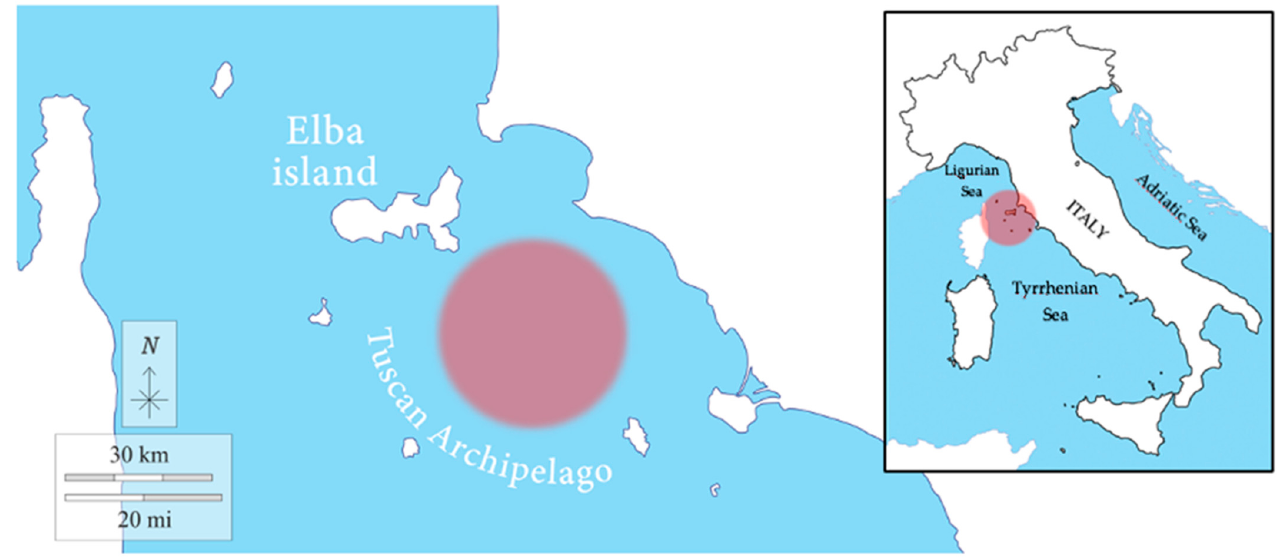
Figure 1. Sampling area. The fishing area of the samples is indicated by the red circle in the figure.